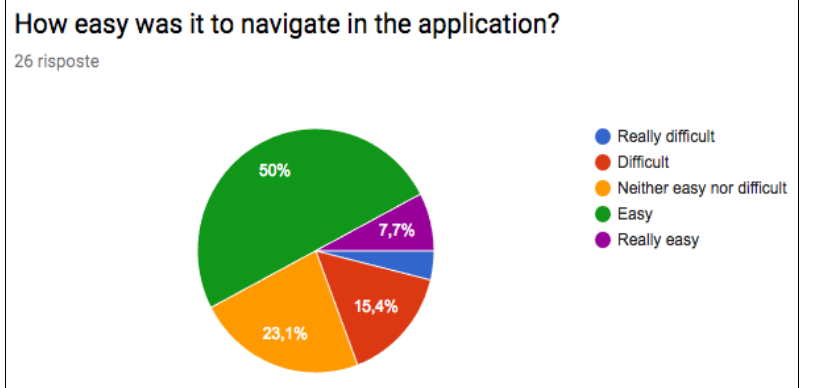
Figure 17. Opinion on navigation in the application